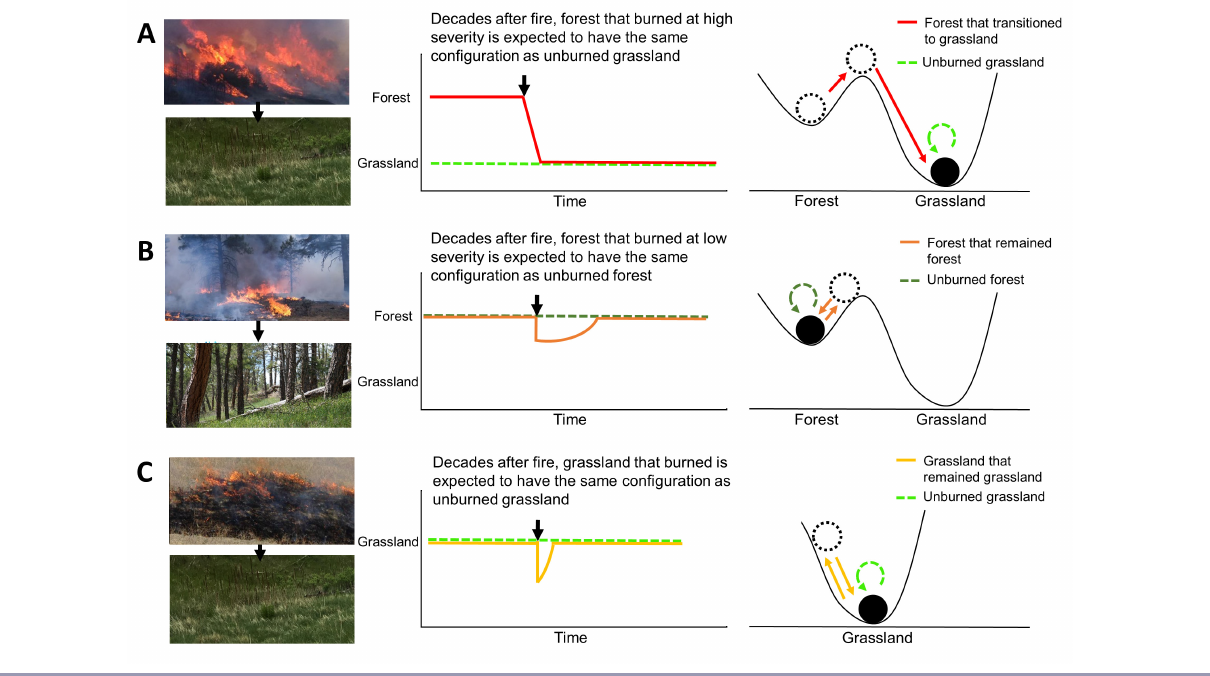
Fig. 1 . Three depictions of predicted responses of alternative forest and grassland regimes that experience fire in eastern ponderosa pine. (A) A representation of a forest that burns at high severity, predicted to resemble an unburned grassland regime. (B) A representation of a forest that burns at low severity, predicted to resemble an unburned forest regime. (C) A representation of a burned grassland, predicted to resemble an unburned grassland regime. Photo credit: Victoria